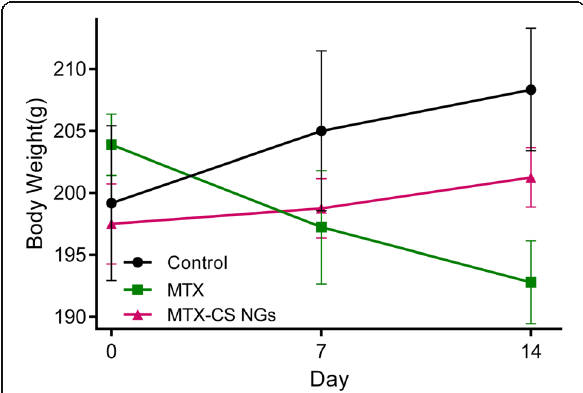
Fig. 6 Effects of MTX and MTX-CS NGs on the rat body weight. The day of the first injection was considered as day 0. Saline, MTX (1.25 μ mol kg − 1 day − 1 ), and MTX-CS NGs (4.25 mg kg − 1 day − 1 ) were given another day by intraperitoneal injections, respectively, to the corresponding group. Results are expressed as mean ± SEM and analyzed using t test. * P < 0.05 compared to the date at day 0